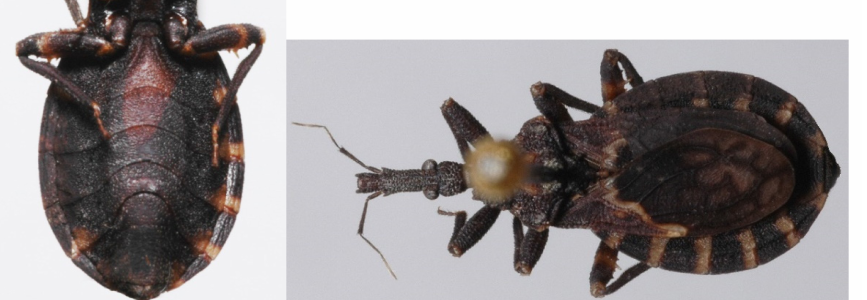
6. -Pronotum with posterior and lateral border light colored. Scutellar process not sulcate. Membrane of hemelytron with base light colored. Abdomen mainly dark connexivum with yellow spots, extending to the border of sternites. Hind femora with a yellow ring